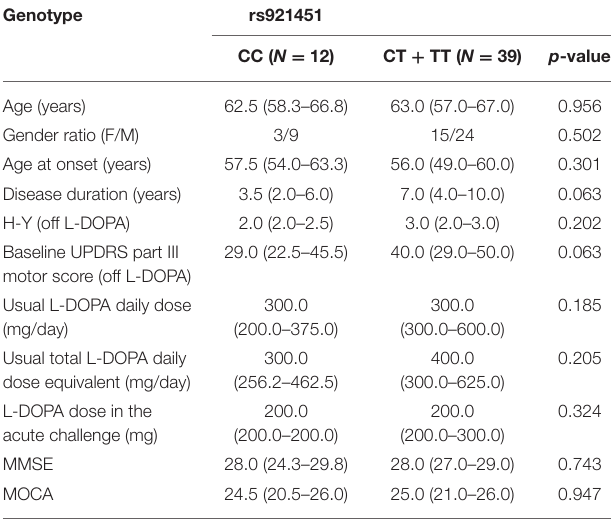
TABLE 2 | Baseline characteristics of the patients in each